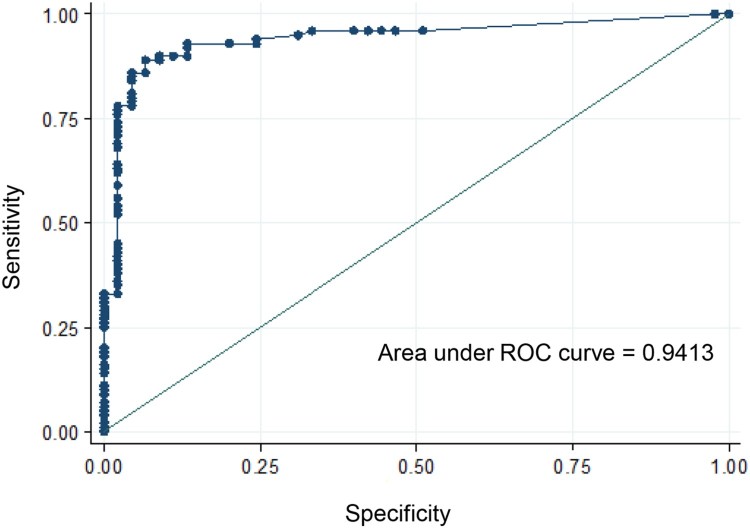
ROC curve to identify mosquitoes capable of disseminating the virus according to the viral load in body.